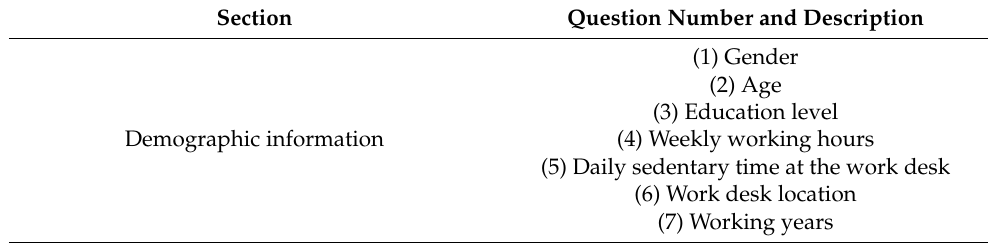
Table 3. Demographic information questions.